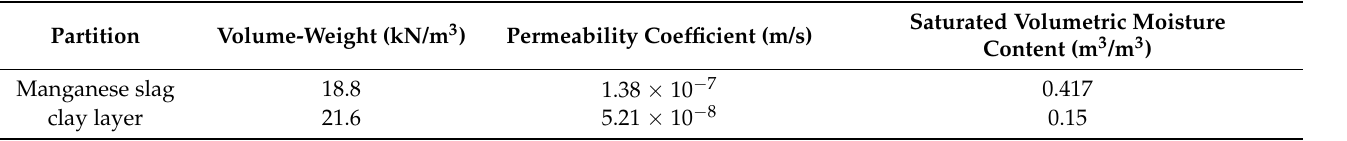
Table 7. Parameters of seepage